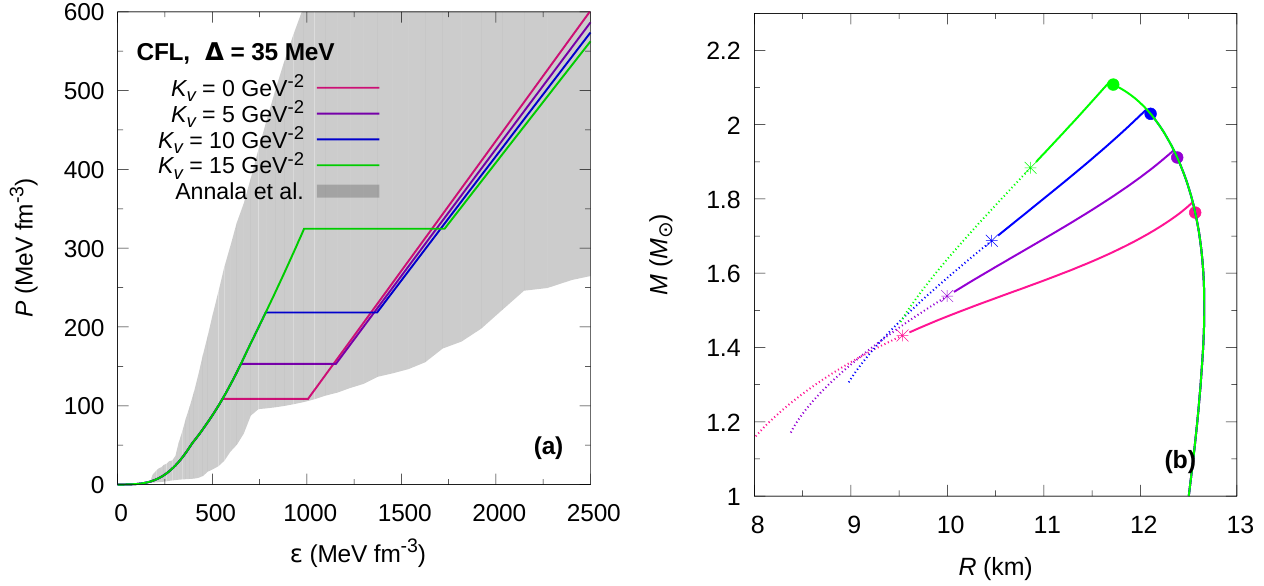
Figure 2. Hybrid EoS (panel ( a )) and mass-radius relationship (panel ( b )) for the CFL phase at fixed gap value of ∆ = 35 MeV, for different values of the K v parameter. In panel ( a ), the grey region shows the constraints presented in [42]. The solid dots in panel ( b ) indicate the appearance of the color superconducting phase, just before the maximum mass peak. For rapid conversions, the stellar configurations to the left of each maximum mass are unstable and the existence of HSs is only marginal. For slow conversions, an extended stability branch exists. The stable configurations are shown by continuous lines. The terminal configurations are marked with